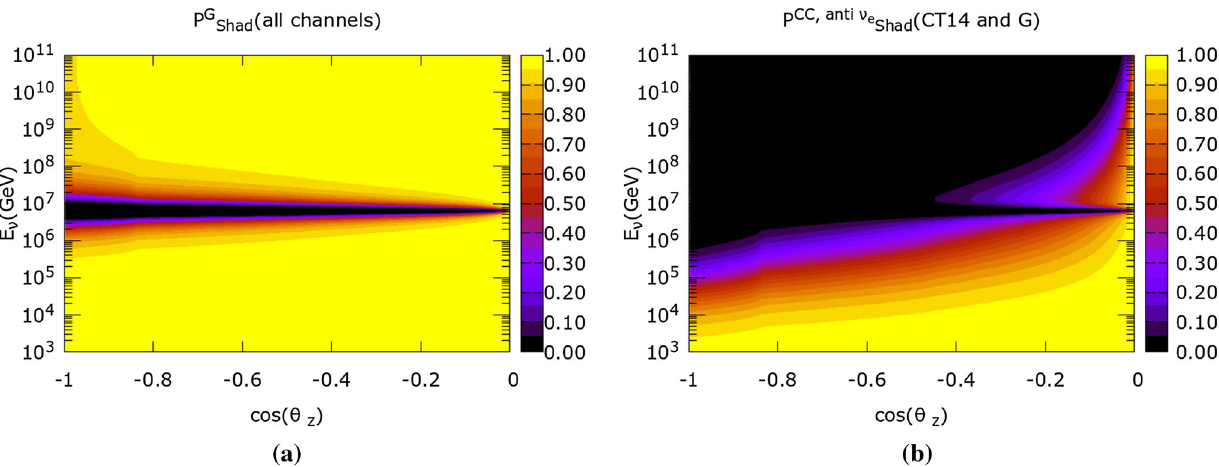
Fig. 6 The energy and angular dependencies of the probability of antineutrino absorption by the Earth, P shad ( E ν ,θ z ) for a the Glashow resonance and b the sum of the contributions associated with the Glashow resonance and antineutrino-hadron cross-section estimated using the DGLAP (CT14) approach 1 − (cid:5) Y ( BBMT ) R Y , Tr =